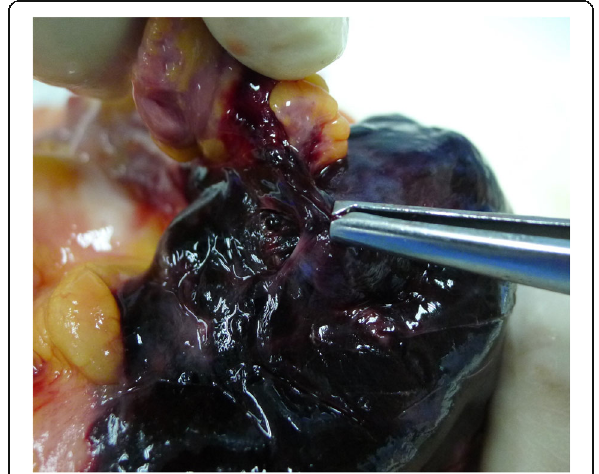
Fig. 3 Ruptured site from underneath the auricle of the left atrium